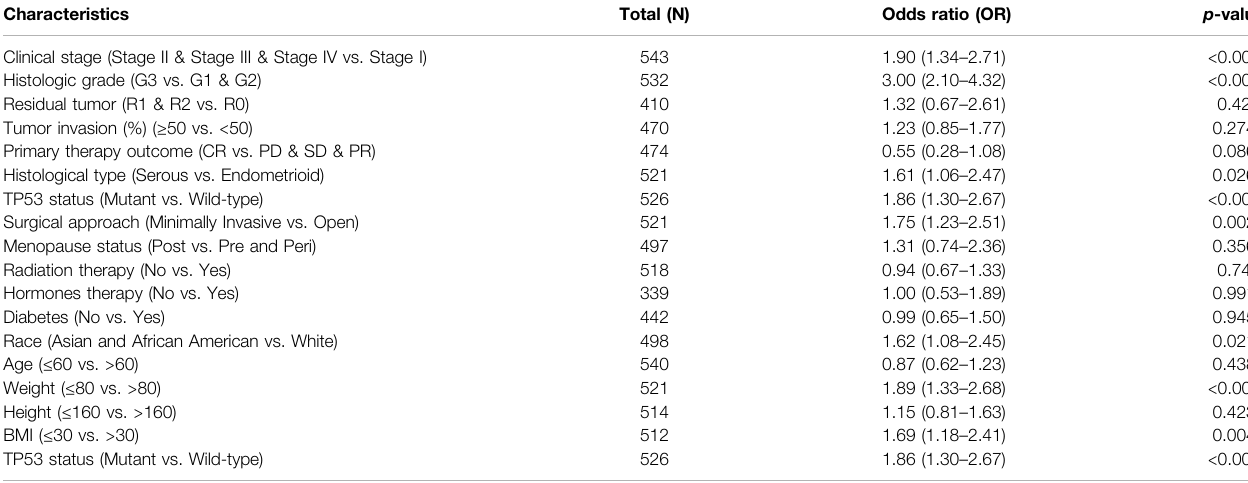
TABLE 2 | Associations of GGH expression a levels with clinicopathological characteristic according to logistic regression analysis. Characteristics